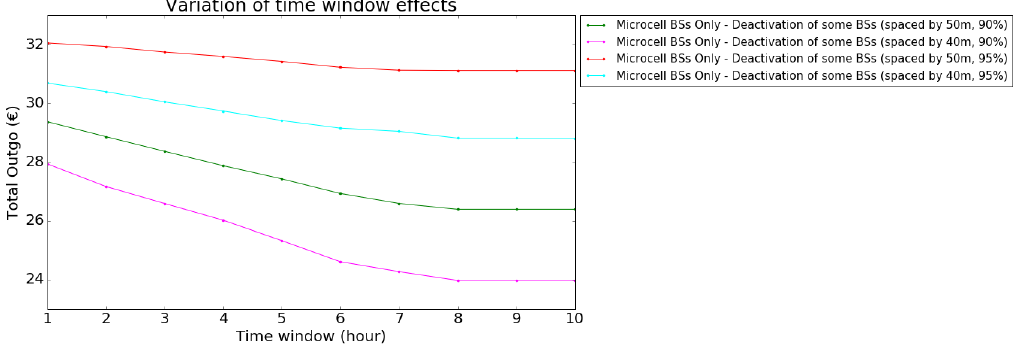
Figure 16. Only Microcell BSs: Deactivation of some BSs . Effects of the time window on the total outgo.